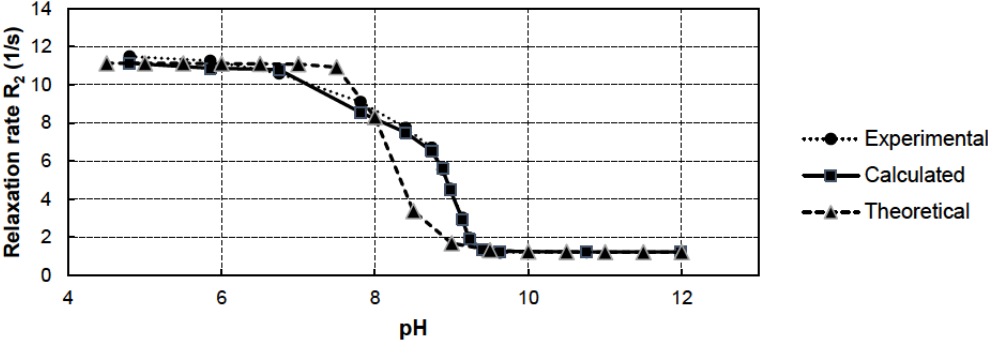
Figure 6: Total relaxation rate R 2 results for mixtures of Mn 2+ , Cu 2+ , Fe 3+ , Fe 2+ and Zn 2+ in mining water as a function of pH.